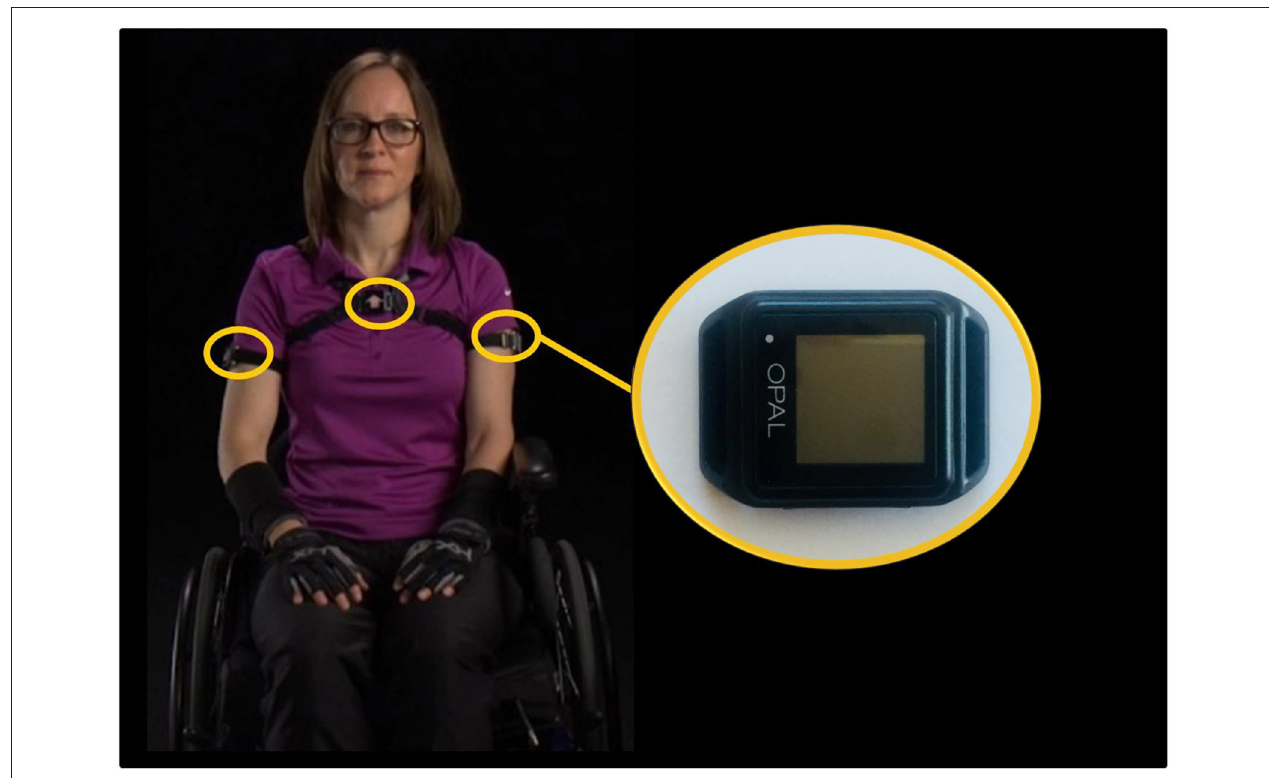
FIGURE 1 | The inertial measurement units were worn by participants on their bilateral upper arms and torso. Note the individual pictured here is a study team